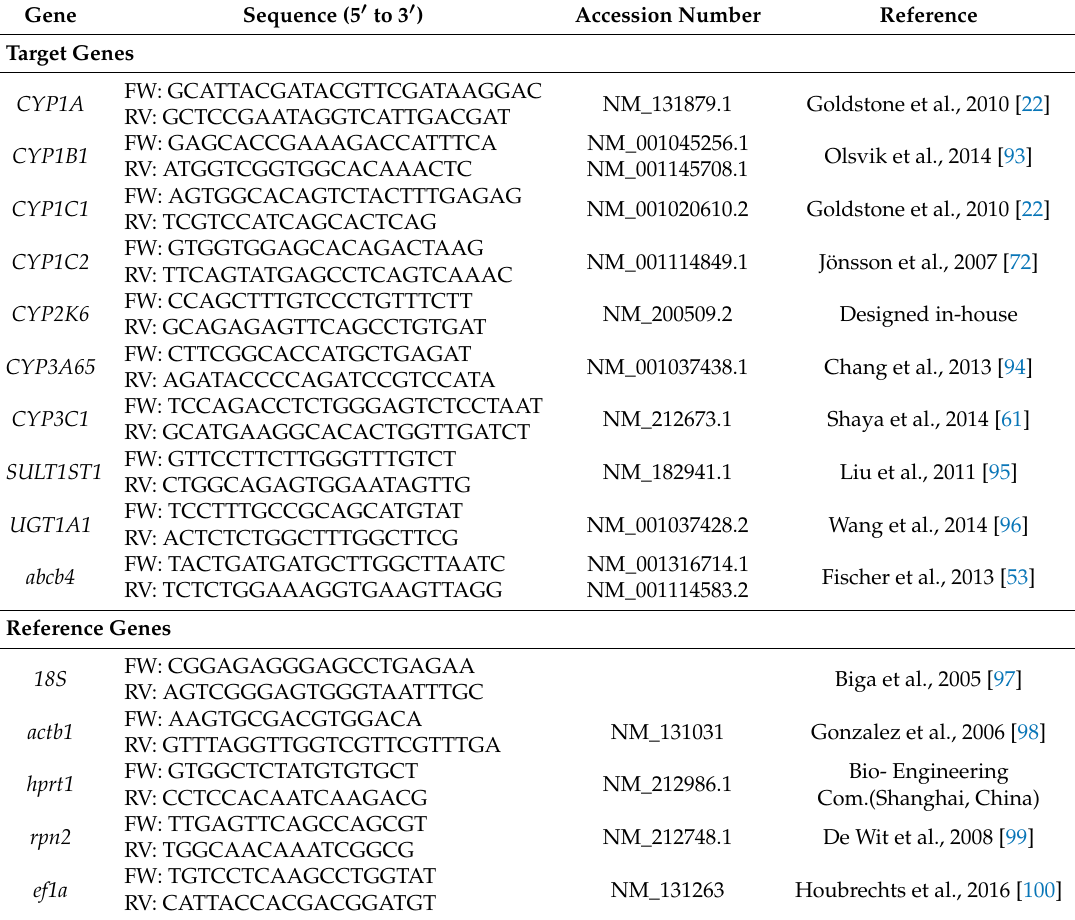
Table 3. Primer sequences of zebrafish target genes and reference genes used for quantitative polymerase chain reaction